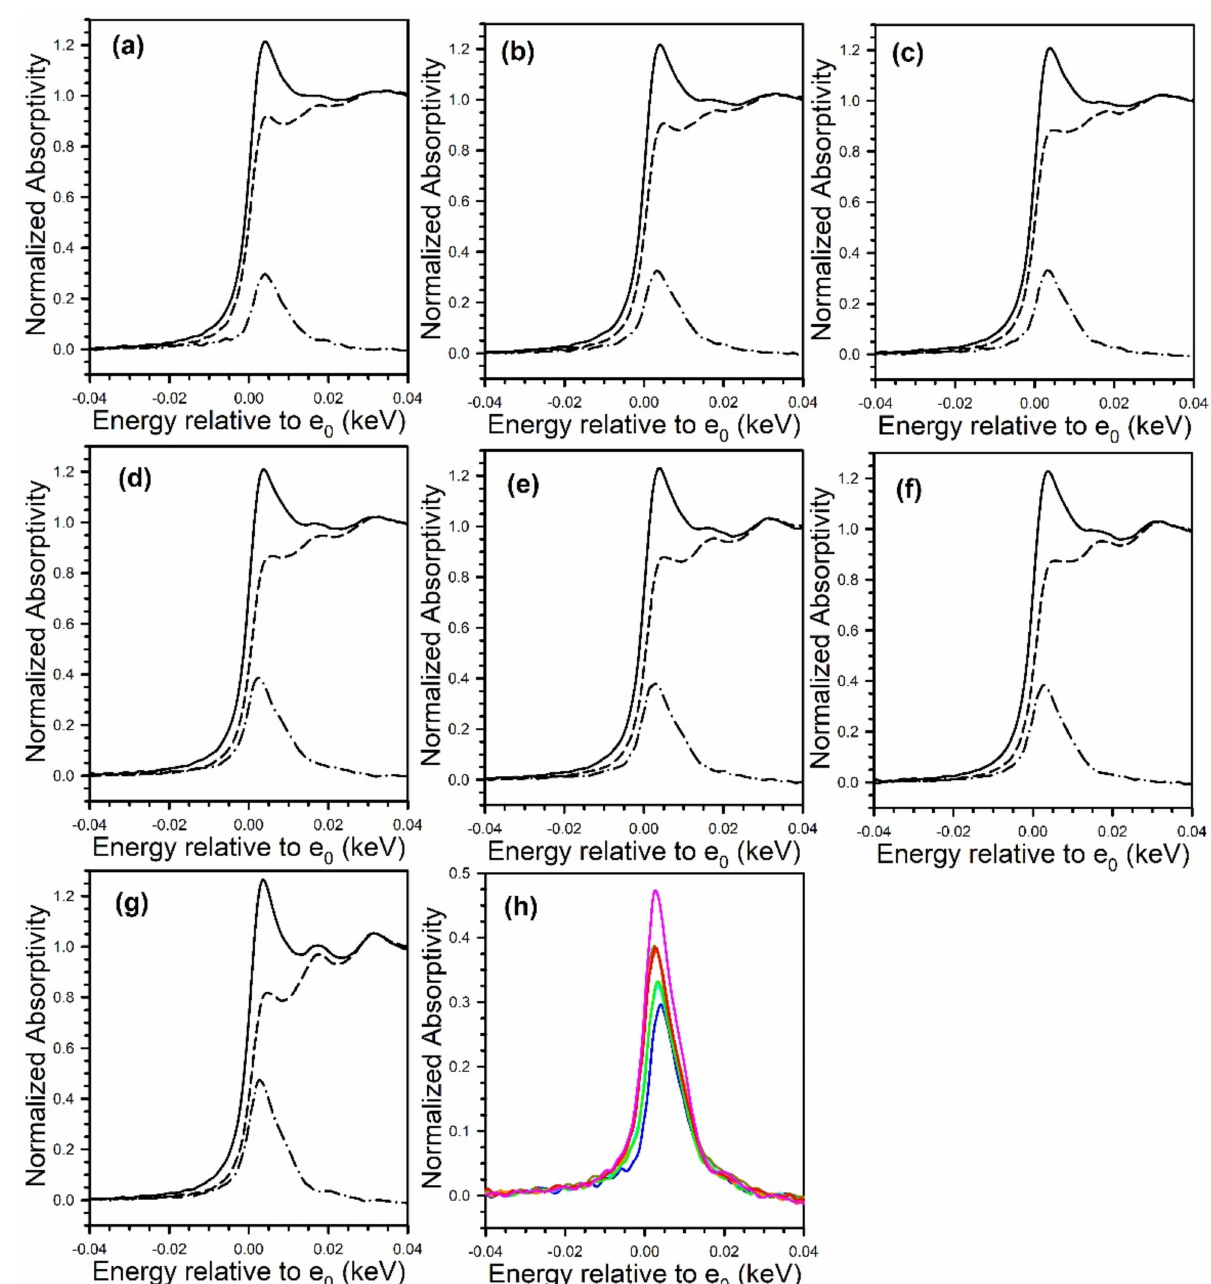
Figure 15. XANES spectra at the Pt (solid line) L 3 edge and (dashed) line L 2 edge, as well as (dash-dotted line) the L 3 -L 2 difference spectra of ( a , blue) 2% Pt/ZrO 2 , ( b , cyan) 0.93% Rb-2% Pt/ZrO 2 , ( c , green) 1.86% Rb-2% Pt/ZrO 2 , ( d , dark yellow) 2.79% Rb-2% Pt/ZrO 2 , ( e , orange) 4.65% Rb-2% Pt/ZrO 2 , ( f , red) 5.58% Rb-2% Pt/ZrO 2 , and ( g , pink) 9.3% Rb-2% Pt/ZrO 2 . ( h ) Overlays of L 3 2212 L 2 difference spectra, showing an increase in intensity with Rb loading. No evidence for e - transfer to Pt from Rb + was found, which should result in an opposite trend. Figure 15 reprinted from [49] with permission from MDPI, copyright